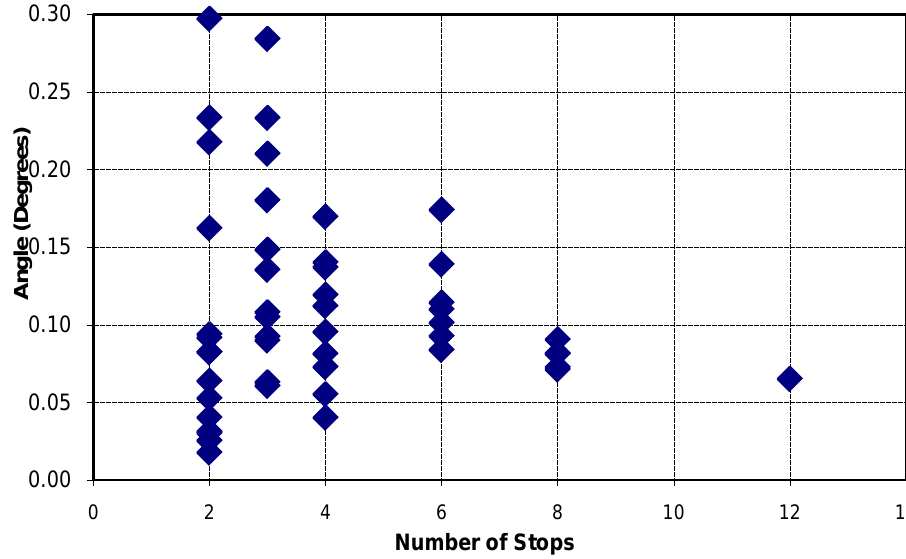
Figure 11. Field Test Results of the DAS showing precision of calculated orientation angle Omega vs. number of device stops for different symmetrical configurations of the device stops; the chart shows the asymptotic nature of the precision curve as the number of device stops approaches 10